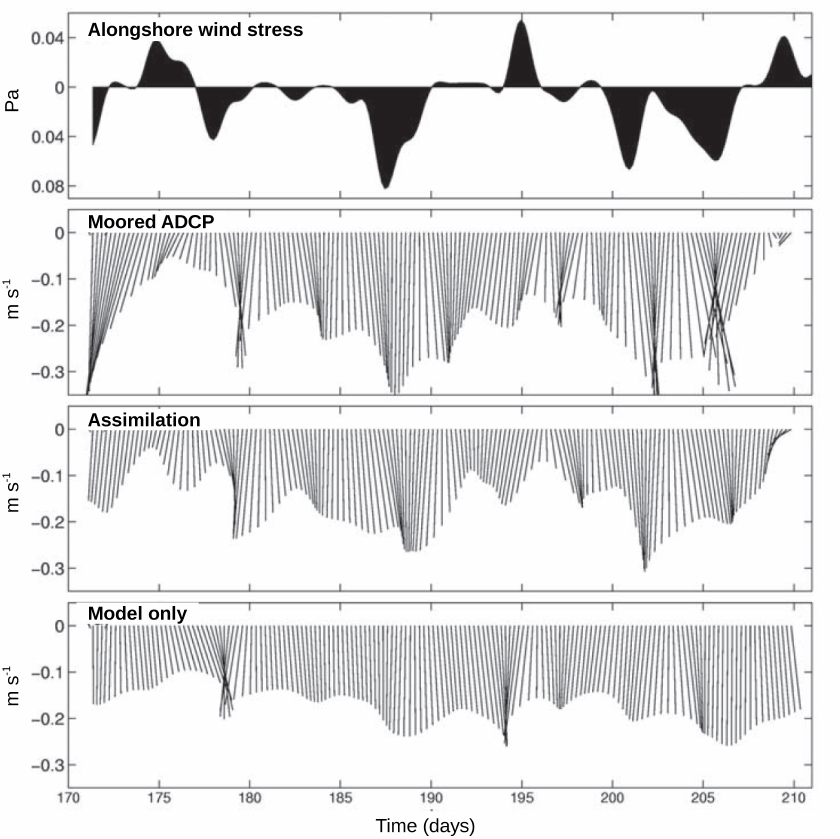
Figure 12. Comparison between the alongshore wind stress and the ocean vertical averaged current during the 40-day experiment. From Fig. 10 in Oke et al.